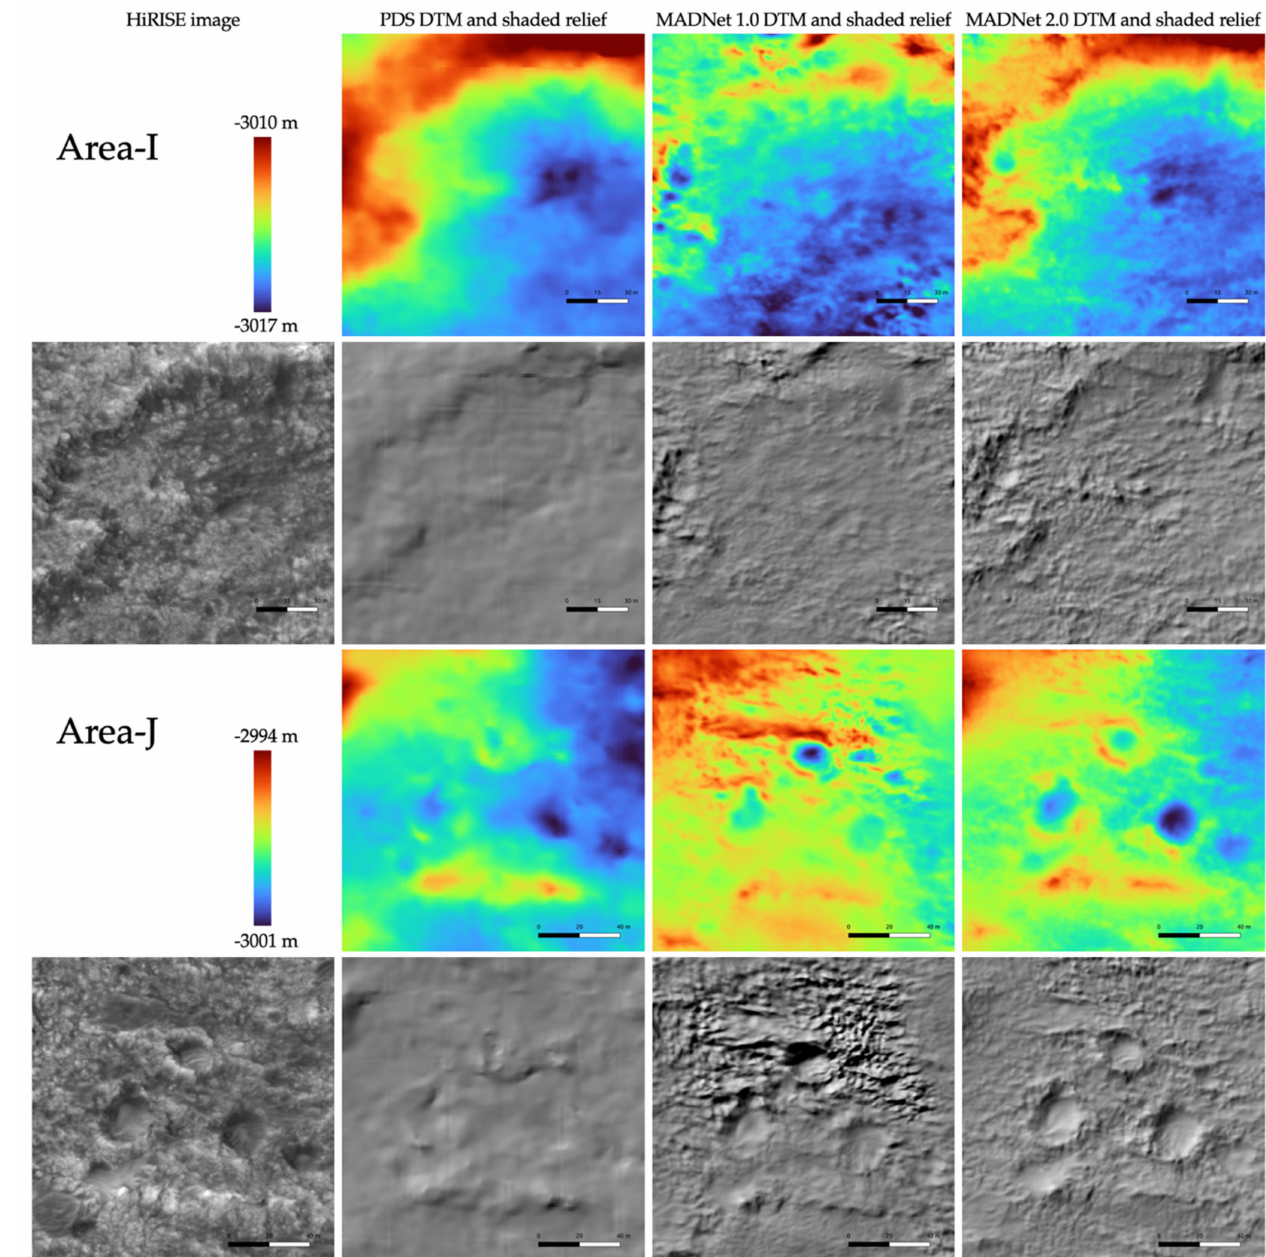
Figure 15. Examples of zoom-in views of the 1 m/pixel PDS HiRISE DTM, 50 cm/pixel MADNet 1.0 DTM, and 25 cm/pixel MADNet 2.0 DTM, produced from a single HiRISE image